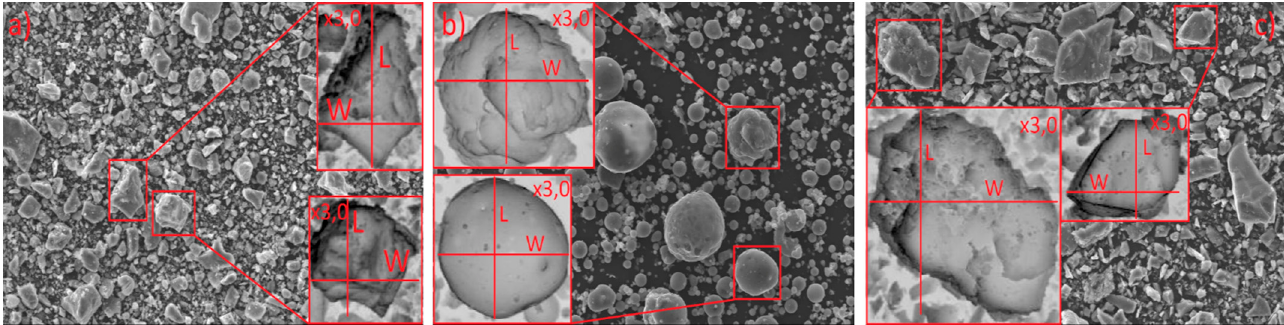
Figure 4. Scanning electron microscope (SEM) analysis of the binders: ( a ) cement CEM I 42.5, ( b ) siliceous fly ash, and ( c ) granite powder.